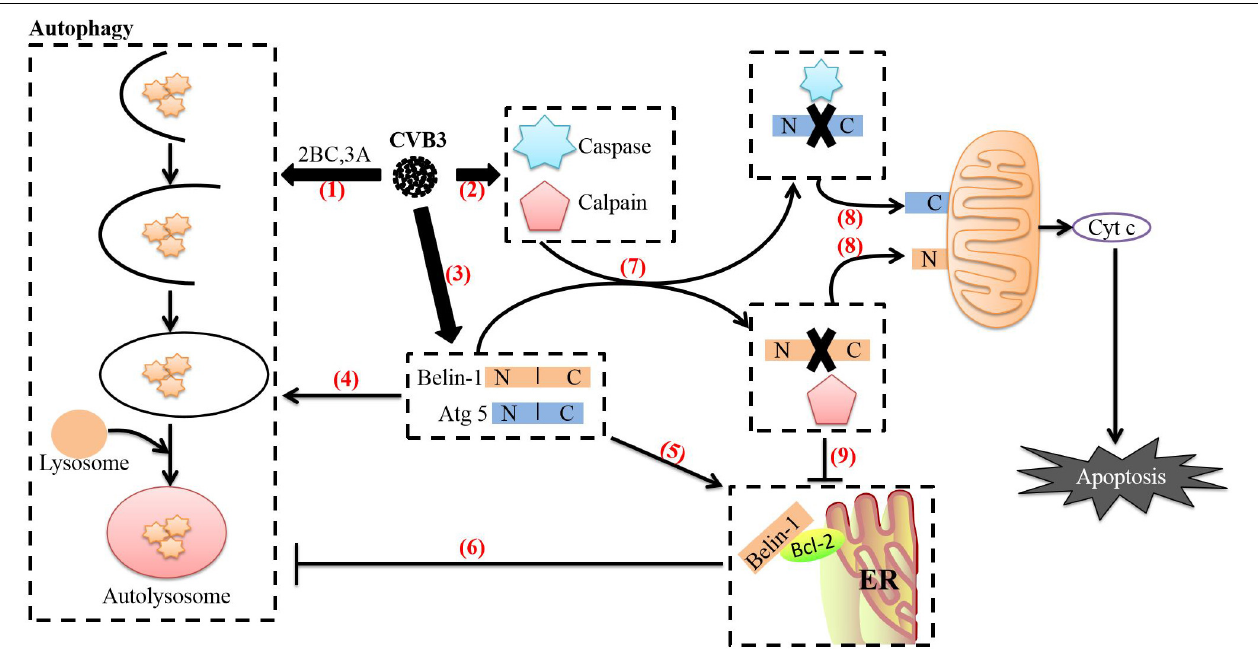
FIGURE 4 | Relationship between autophagy and apoptosis induced by CVB3. (1) After CVB3 infects cells, it uses viral proteins (such as 2BC and 3A) to induce autophagy. (2) The direct actions of viral proteins (such as 3C and 2A) or the cell’s defense mechanisms then activate caspases and calpain through various pathways. (3) The transcription and translation of full-length ATG5 and beclin-1 in CVB3-infected cells continue to increase. (4) Beclin-1 aids in autophagosome initiation and autophagosome blockade, Atg5 aids in autophagosome extension, and Beclin-1 can stimulate high levels of autophagy. (5) Endoplasmic reticulum-localized Bcl-2 can form a complex with Beclin-1. (6) Upon forming a complex with Bcl-2, Beclin-1 loses its ability to induce autophagy. (7) Beclin-1 is cleaved by caspases, while Atg5 can be cleaved by calpains. (8) The C-terminal cleavage product of Beclin-1 is transferred to mitochondria and induces Cyt c release; the N-terminal cleavage product of Atg5 is also transferred to mitochondria and induces Cyt c release after binding to Bcl-xL. The release of cyt c into the cytoplasm leads to apoptosis. (9) Caspase-mediated destruction of the Beclin-1-Bcl-2 complex promotes autophagy. The image content has been adapted from other articles in the literature (Gordy and He, 2012; Jiang et al.,